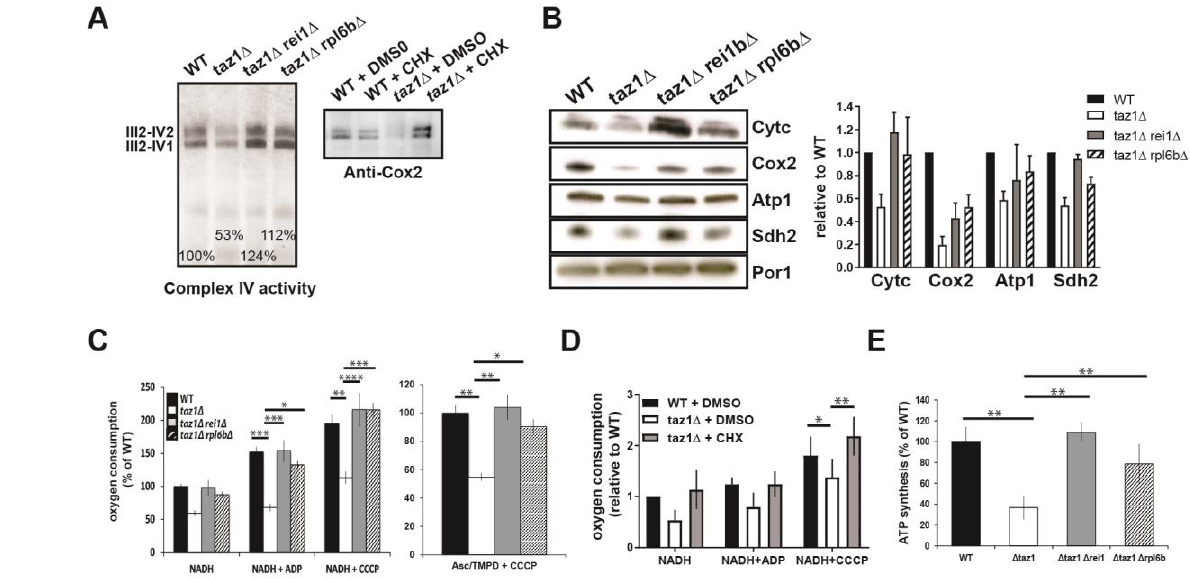
FIGURE 3: Partially decreasing cytosolic translation preserves oxidative phosphorylation in taz1 Δ yeast. The experiments here described were performed using mitochondria isolated from cells grown for 24 hours at 36°C in CSM containing 0.5% galactose + 2% ethanol, supple- mented or not as indicated with 10 nM CHX, until a density of 2-3 OD 600nm . (A, B) Steady-state levels of proteins involved in the transfer of electrons to oxygen. (A) Proteins were extracted from the mitochondrial samples using 2 g digitonin per g of proteins. The supercomplexes III 2 -IV 2 and III 2 -IV 1 were revealed by the complex IV activity after separation by CN-PAGE or by western blot with antibodies against Cox2 in BN-PAGE gels. (B) Left panel. Total mitochondrial protein samples were resolved by SDS-PAGE (50 μg per lane) and probed with antibodies against the indicated proteins. The shown gels are representative of at least 3 experiments. Right panel. Quantification using ImageJ soft- ware. Levels of Cytc, Cox2, Atp1 and Sdh2 are normalized to Por1p and expressed relative to WT. (C) Genetic ablation of REI1 or RPL6B in taz1 Δ yeast preserves mitochondrial respiration. On the left are the rates of oxygen consumption from NADH (4 mM) alone (state 4), after further addition (150 μM) of ADP (state 3) or CCCP (4 μM) (uncoupled respiration). The data are expressed in % of WT state 4 respiration (mean ± s.d, n=4). On the right are the oxygen consumption rates from electrons delivered directly to complex IV by ascorbate 12.5 mM/TMPD 1.4 mM in the presence of CCCP. Data are expressed relative to the WT (mean ± s.d, n=4). (D) Mitochondrial respiration is pre- served in taz1 Δ yeast grown in the presence of 10 nM CHX. NADH was used as the electron donor, as described in panel C (n=4). (E) ATP synthesis was measured using NADH as a respiratory substrate in the presence of 1 mM ADP. Data are expressed as mean ± s.d. (n=4) rela- tive to the WT. The data for WT and taz1 Δ strains were reported previously [60]